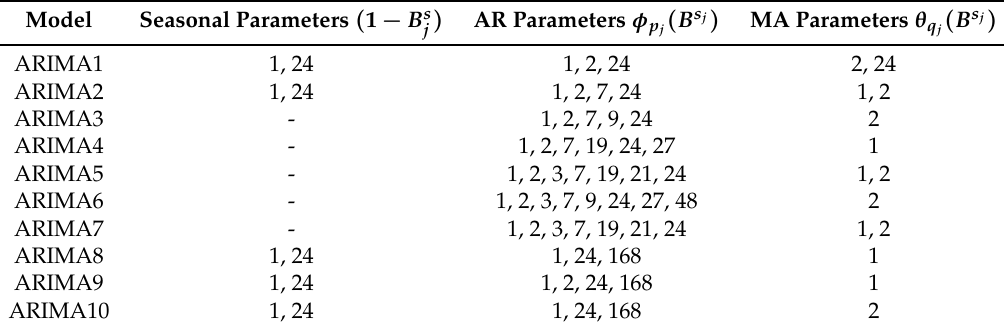
Table 3. Terms of the ARIMA